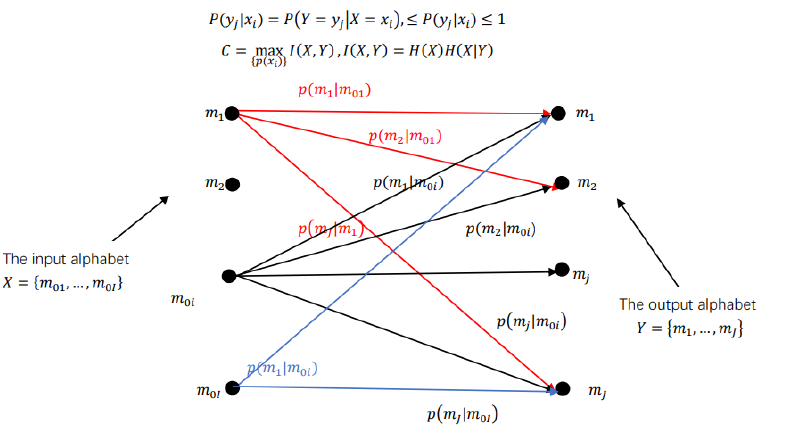
Figure 2. Discrete memoryless channel among the energy levels of signal OAM and received